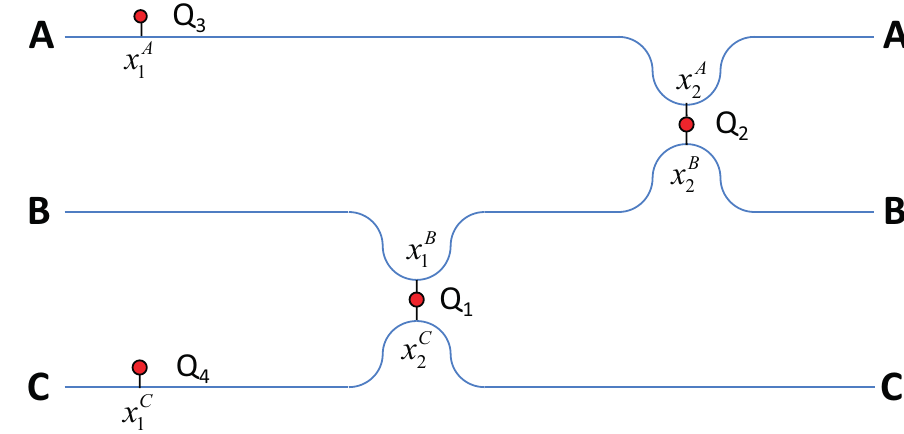
Figure 1. The scheme of quantum router: sketch of the system constructed from three waveguides and four qubits at coordinates x J , where I means position at the J th waveguide ( J = A , B , C I